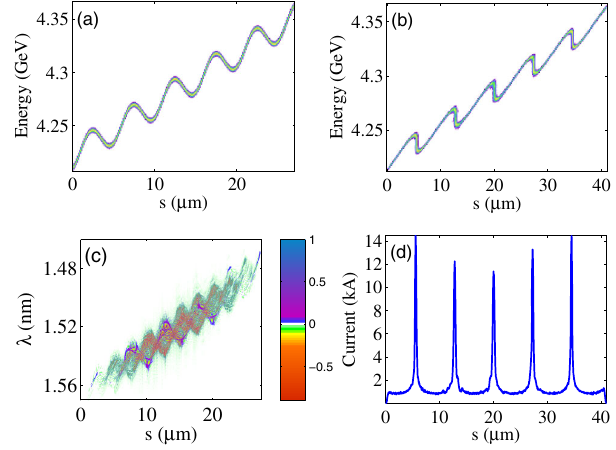
FIG. 2. Electron beam longitudinal phase space before the SASE undulator (a) and after the bypass chicane (b). The Wigner transformation of the SASE field generated in U1 is shown in (c), and the electron current profile after the bypass chicane is show in (d). The electron bunch head is to the